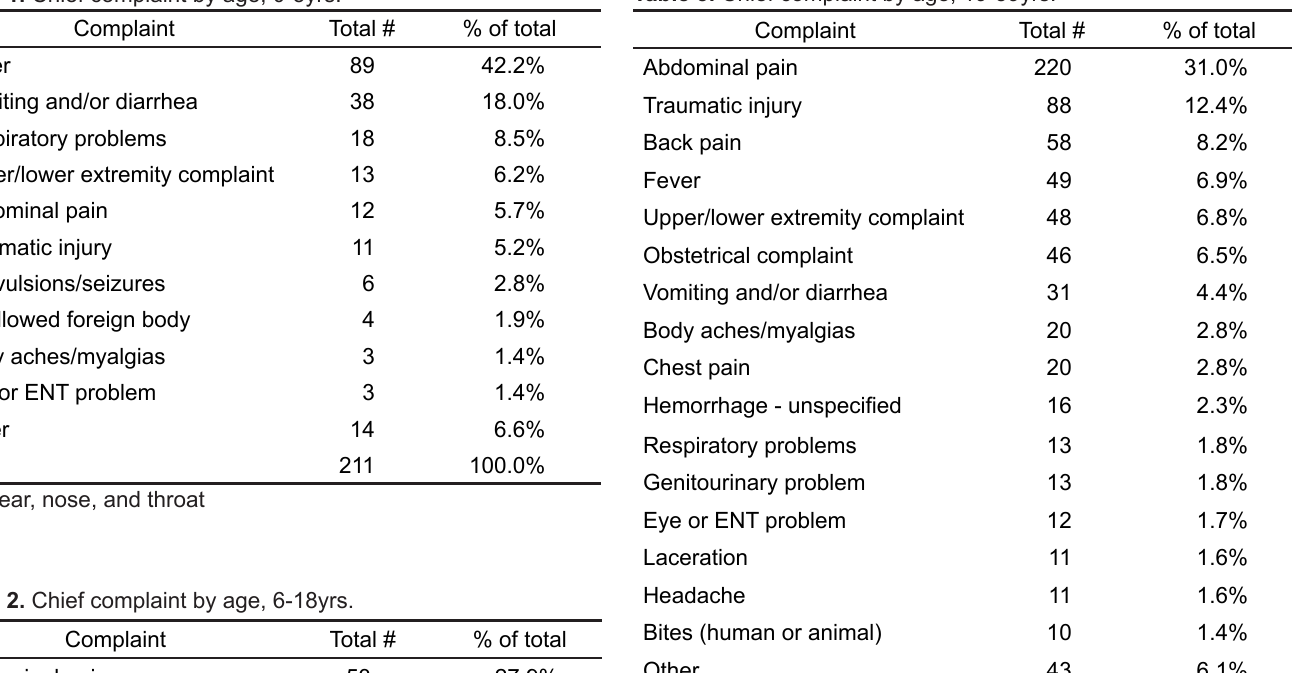
Table 3. Chief complaint by age, 19-59yrs.